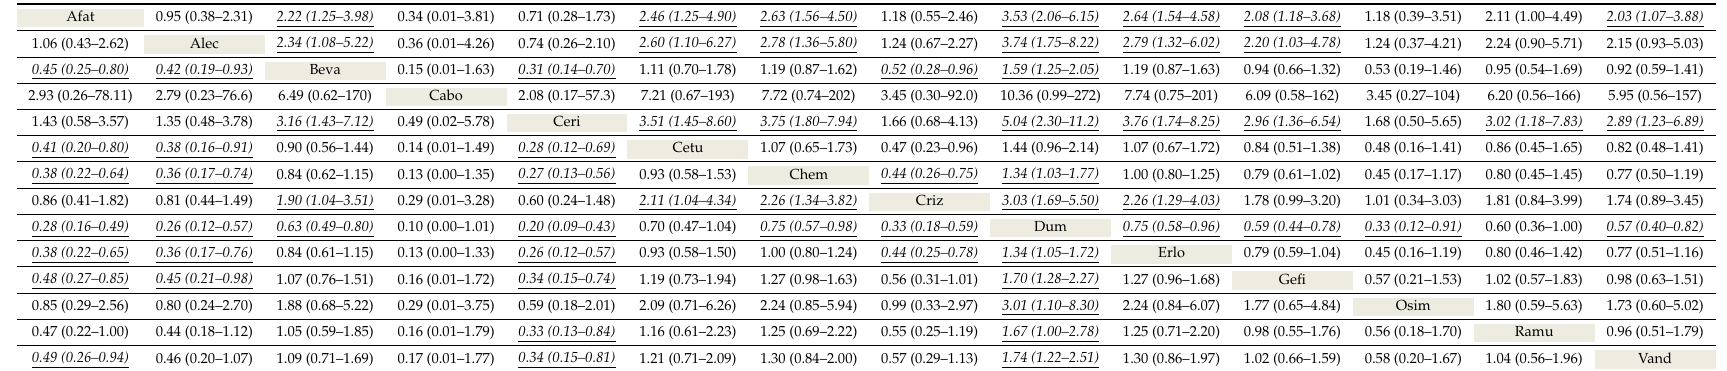
Drugs are reported in alphabetical order. Data in the right-upper triangle are RRs (95% confidence interval, CI) in the row-defining treatment compared with the column-defining treatment. RRs higher than 1 favor the row-defining treatment (the first drug in alphabetical order). RRs for the opposite comparison of ORR are in the left-lower triangle. Each comparison is shown twice in the table, once with drug A vs. drug B and once with drug B vs. drug A. Significant results are in italic and underscored. RR, response ratio; CI, confidence interval; ORR: overall response rate; Afat, afatinib; Alec, alectinib; Beva, bevacizumab; Cabo, cabozantinib; Ceri, ceritinib; Cetu, cetuximab; Chem, chemotherapy; Criz, crizotinib; Dum, dummy; Erlo, erlotinib; Gefi, gefitinib; Osim, osimertinib; Ramu, ramucirumab; Vand,